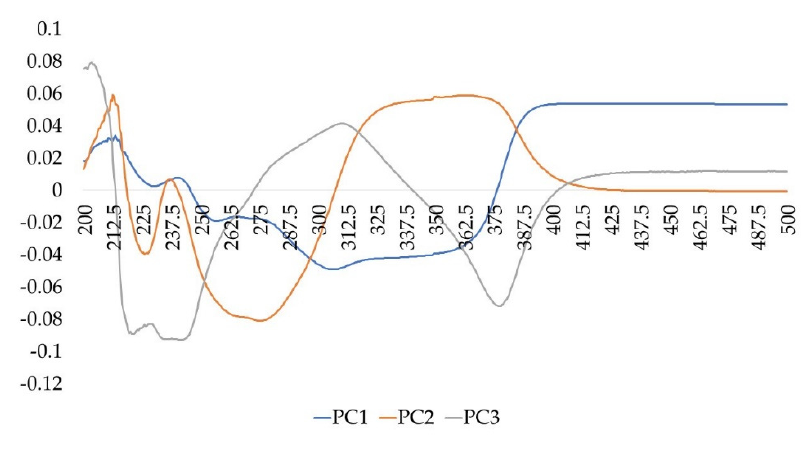
Figure 4. Loading plot on PC1, PC2, PC3.